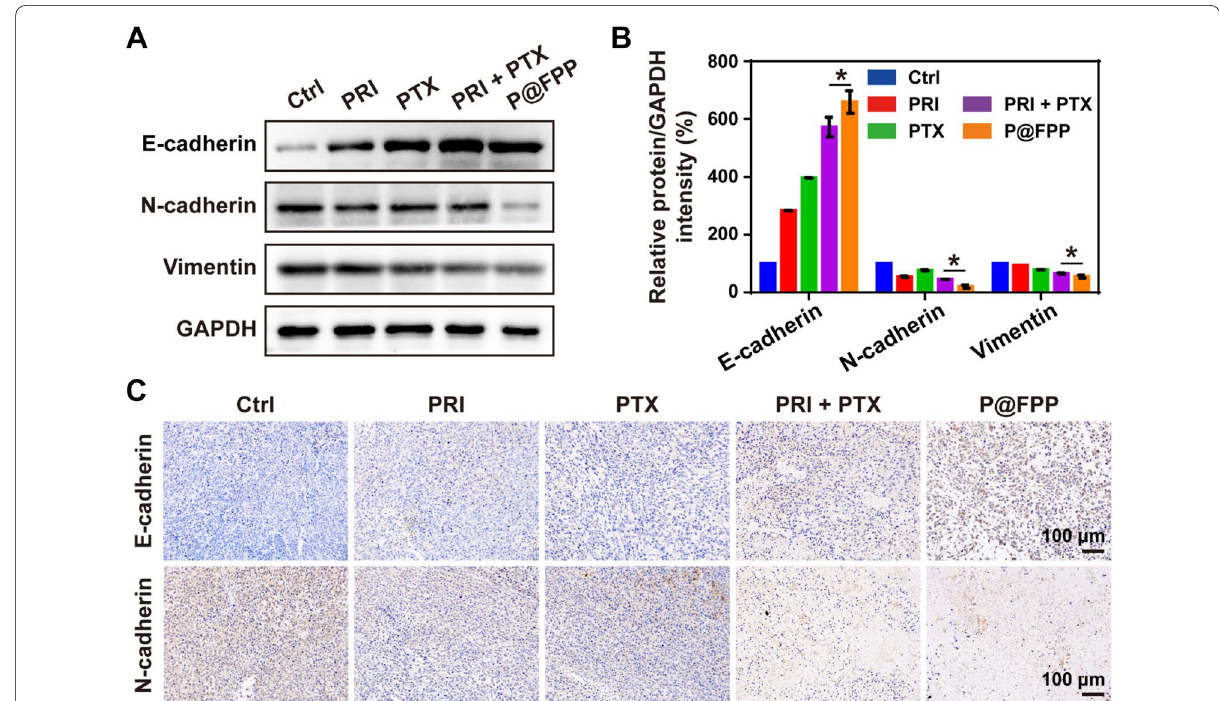
Fig. 8 EMT inhibition of P@FPP NMs in vivo. A–B Western blot and corresponding quantitative analysis of E-cadherin, N-cadherin, and Vimentin protein levels in tumor tissues (n 3). C IHC for E-cadherin an N-cadherin of tumor tissues. scale bar: 100 μm. *: P < =